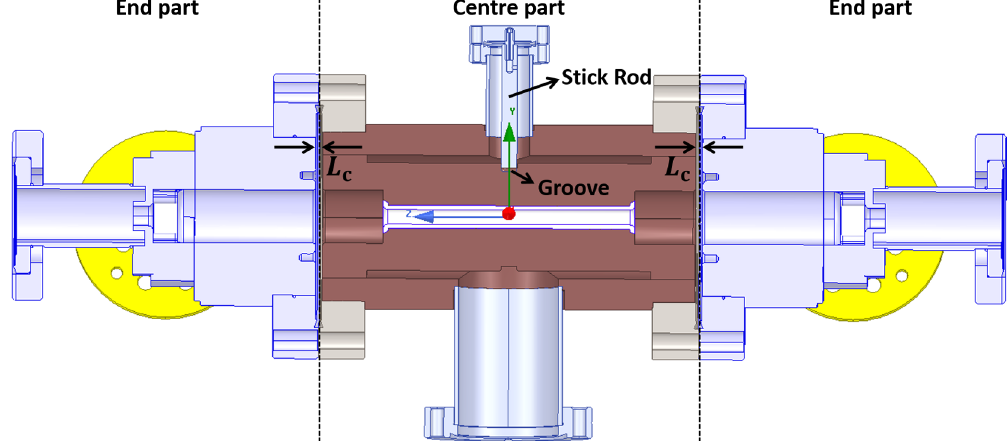
FIG. 13. Full-assembly mechanical design for the whole structure, including a center part and two end